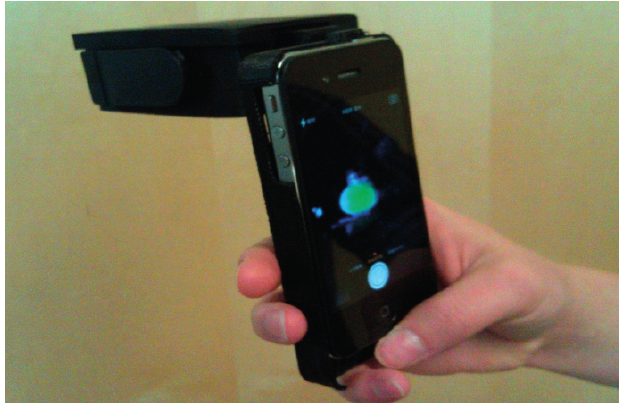
Figure 1. 3D-printed housing with blue LED light (located inside housing) and detachable, 3D-printed iPhone 4 holder (shown without transmission grating). The system quickly connects different smartphone models to the housing, using an Archimedes screw design, while minimizing ambient